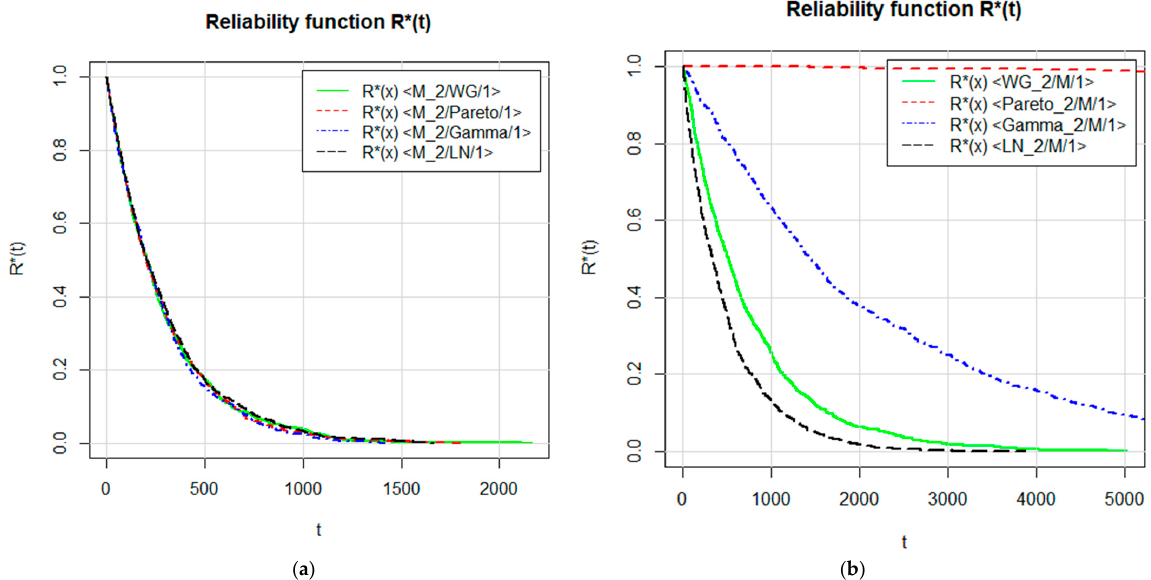
Figure 6. Graphs of the reliability function obtained by the simulation model.